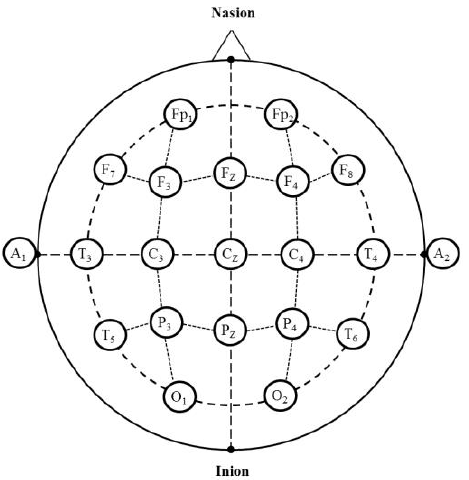
Figure 3. The electrode placement sites according to the international 10–20 system. Fp: frontopolar (Prefrontal); F: frontal; C: Central; T: temporal; P: parietal; O: occipital; A: auricular; z (zero): sagittal midline; odd numbers—left side, even numbers—right side.